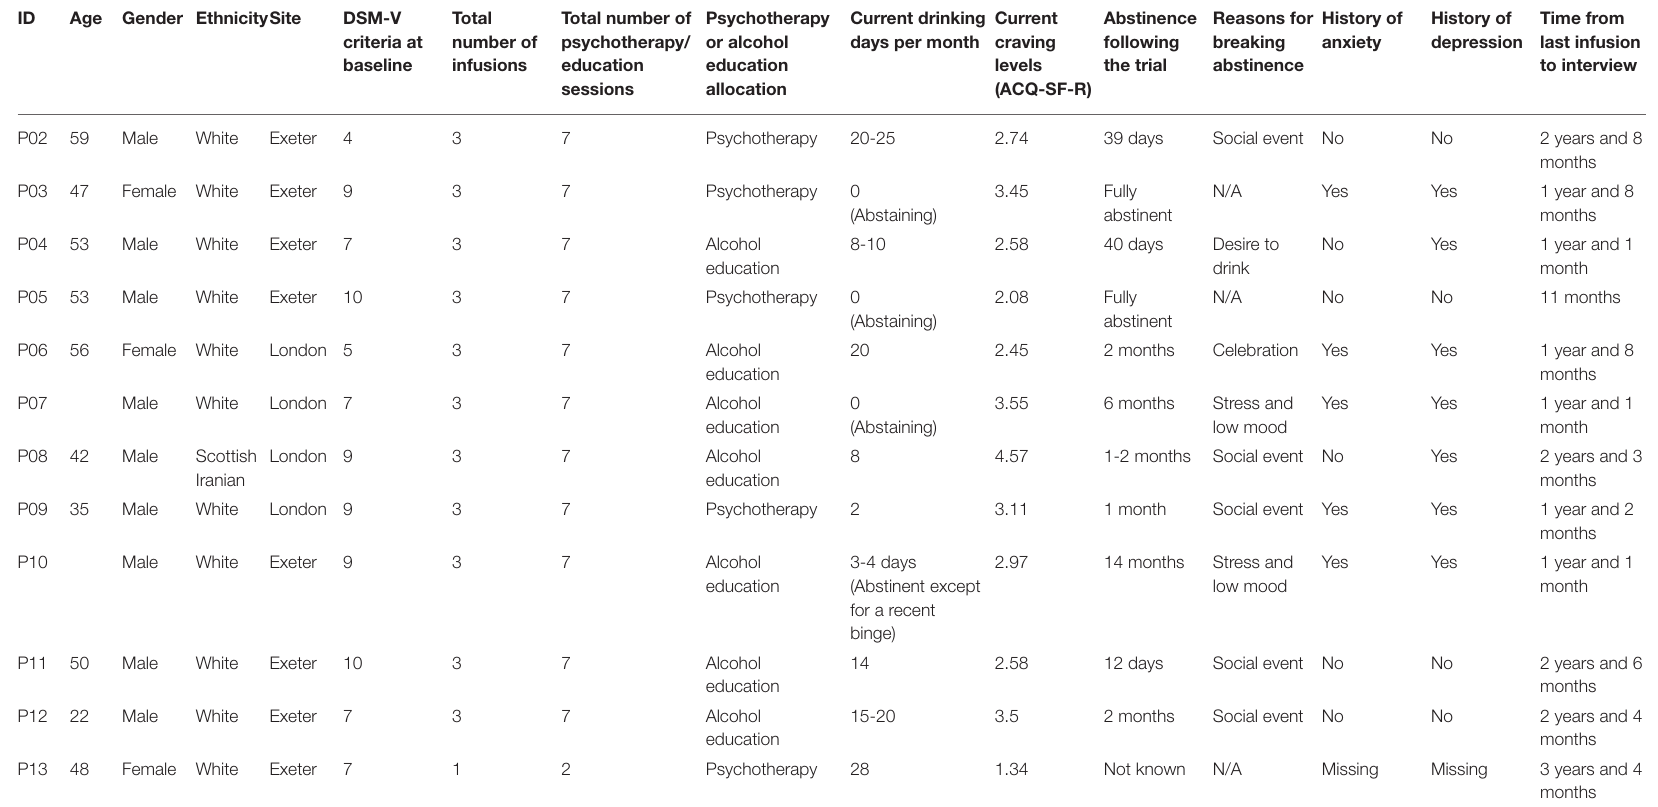
TABLE 1 | Demographic and clinical characteristics of